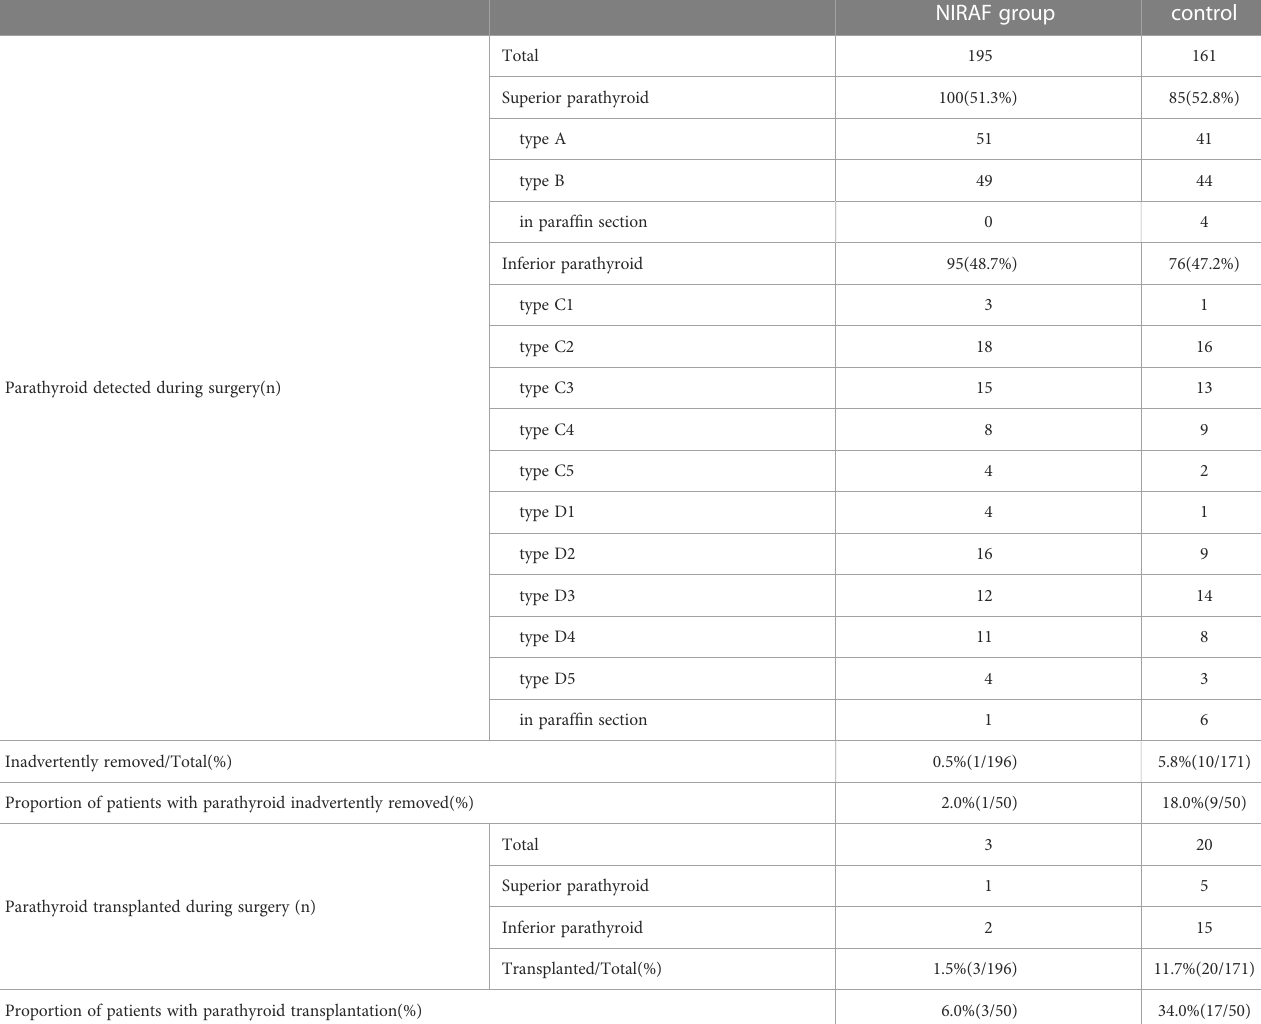
TABLE 2 Statistics for the parathyroid gland parameters in the two